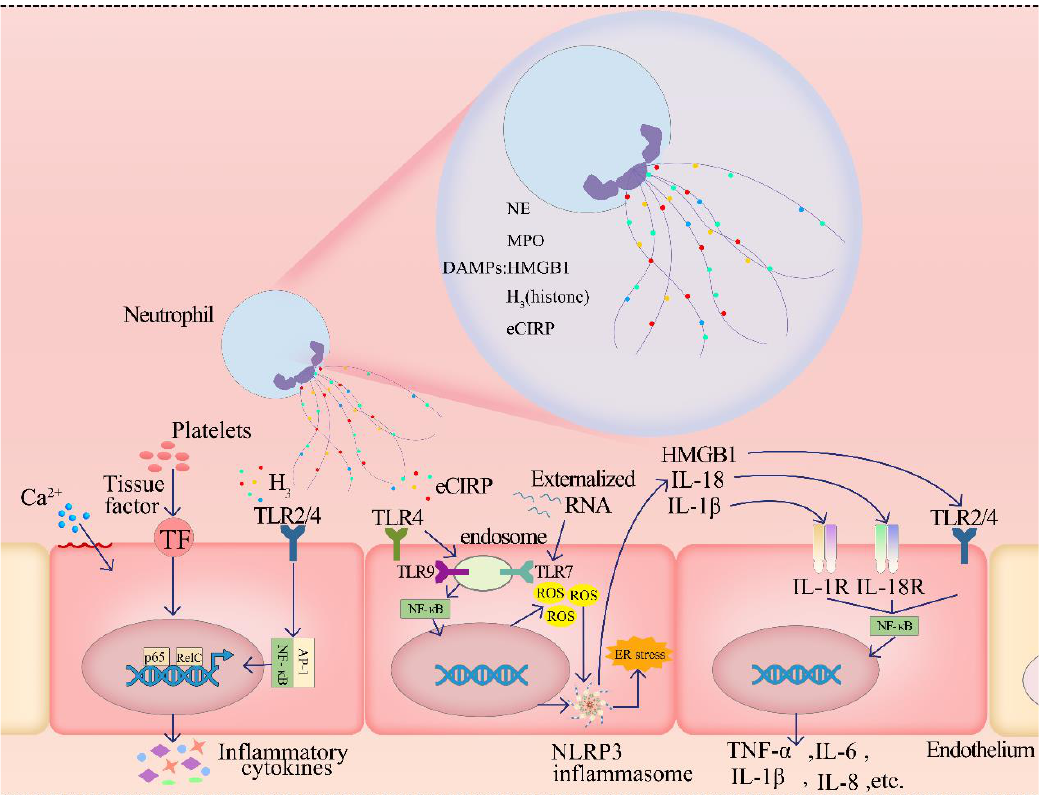
Figure 2. After neutrophil formation of NETs, damage-associated molecular patterns (DAMPs) are released by NETs. Histones selectively bind to Toll-like receptors (TLR) at different concentrations, leading to the activation of NF- κ B and the transcription of AP-1. On the one hand, this may cause ECs to release inflammatory cytokines to amplify the inflammatory response. On the other hand, it promotes the expression of tissue factor (TF) and leads to platelet aggregation. Finally, all of them cause damage to the function of ECs. In addition, the binding of histone to EC membrane can